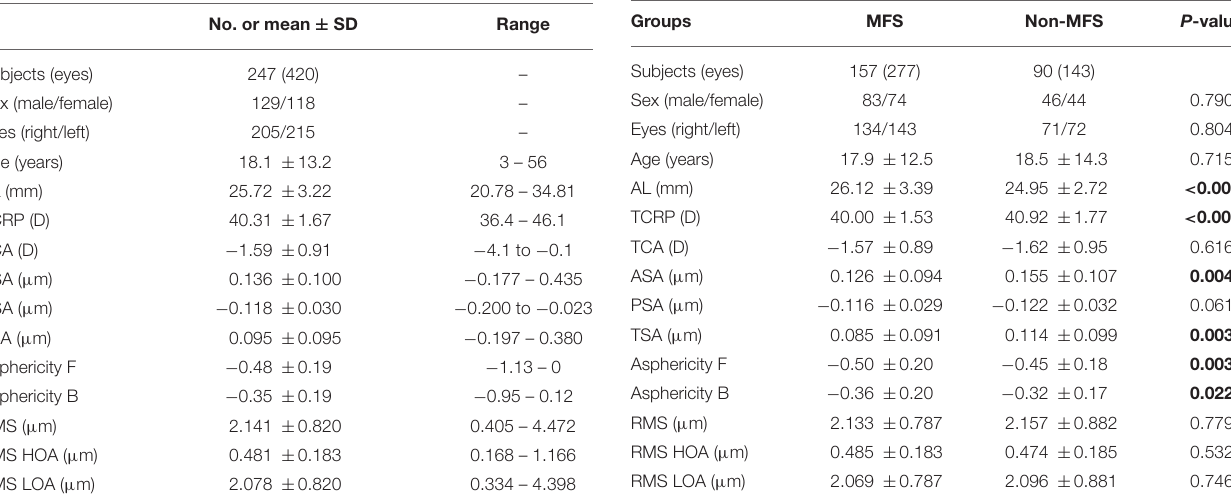
TABLE 1 | Demographic and ocular characteristics in Chinese patients with bilateral ectopia lentis.